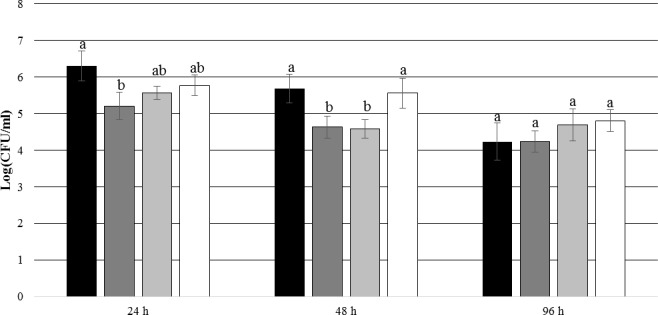
Number of attached P. inhibens wt with either E. huxleyi or f/2 medium inside the chamber. Grouping based on ANOVA post hoc Tukey test. Groups within each sampling time that do not share a letter are significantly different (24 h: P = 0.018; 48 h: P = 0.007; 96 h: P = 0.220).
P. inhibens wt with E. huxleyi, experimental membranes;
P. inhibens wt with E. huxleyi, blinded membranes;
P. inhibens wt with f/2 medium, experimental membranes;
P. inhibens wt with f/2 medium, control membranes.